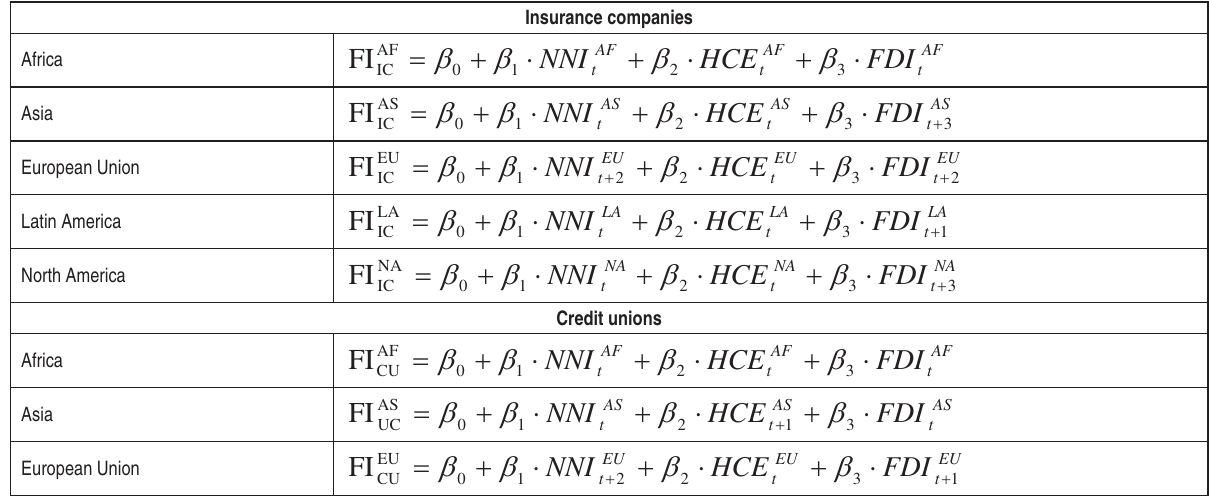
Table 3. Distribution-lag models for cooperation evaluation between expansion of access to insurance companies’ and credit unions’ services and financial and economic development parameters of the